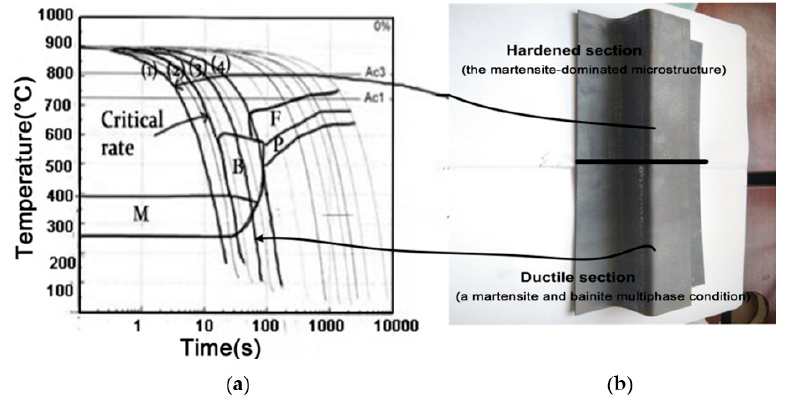
Figure 1. Phase composition: ( a ) prediction based on the continuous cooling transformation (CCT) diagram for B1500HS steel [6], ( b ) in examined U-shaped parts.